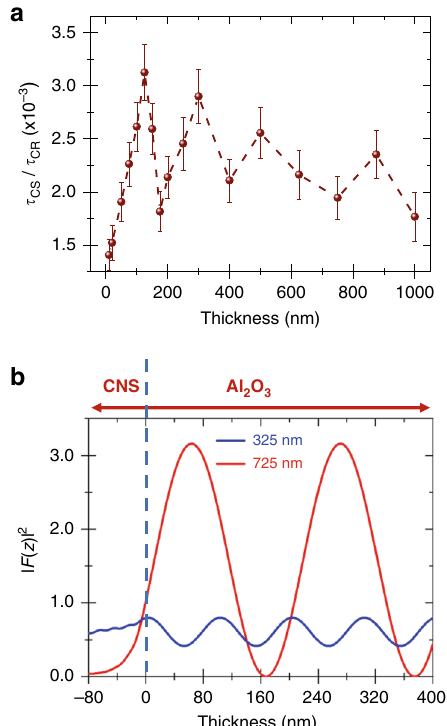
Fig. 2 Analysis of charge-transfer dynamic and optical fi eld in composite nanostructures. a Variations of charge separation (CS) and charge recombination (CR) ratio as a function of the Al 2 O 3 top-layer thickness. b Optical- fi eld intensity distributions of both pump (325 nm) and probe (725 nm) beams across the Al 2 O 3